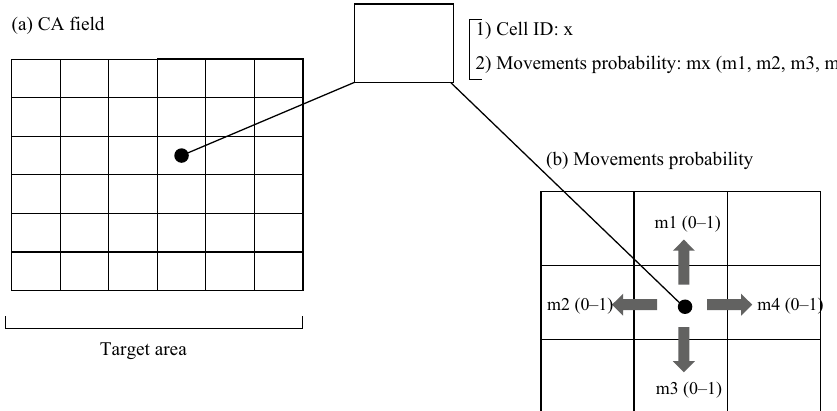
Figure 3. Basic structure of the cellular automaton model. ( a ) Two values are associated with each cell: the cell ID “x,” a unique ID for each cell, and the movement probability “mx” indicating four directional vectors into adjacent cells. ( b ) Values m1, m2, m3, and m4 indicate the probability of movement along a path of the top, left, bottom, and right cells, respectively. If all movement probability values are 0, the virtual population in this cell cannot move to any other cell. If all movement probability values are 1, the virtual population in the cell can move to all adjacent